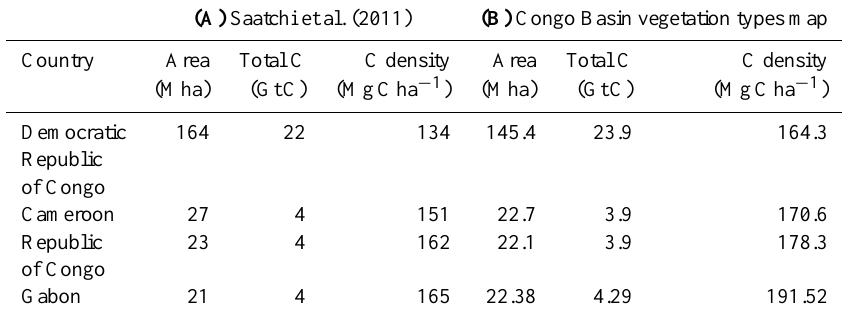
Table 9. (A) Estimates of forest carbon stocks in the 4 largest national pools in Central Africa (Saatchi, 2011) and (B) Estimates of forest carbon stocks from Congo Basin vegetation types map for a 30% canopy cover